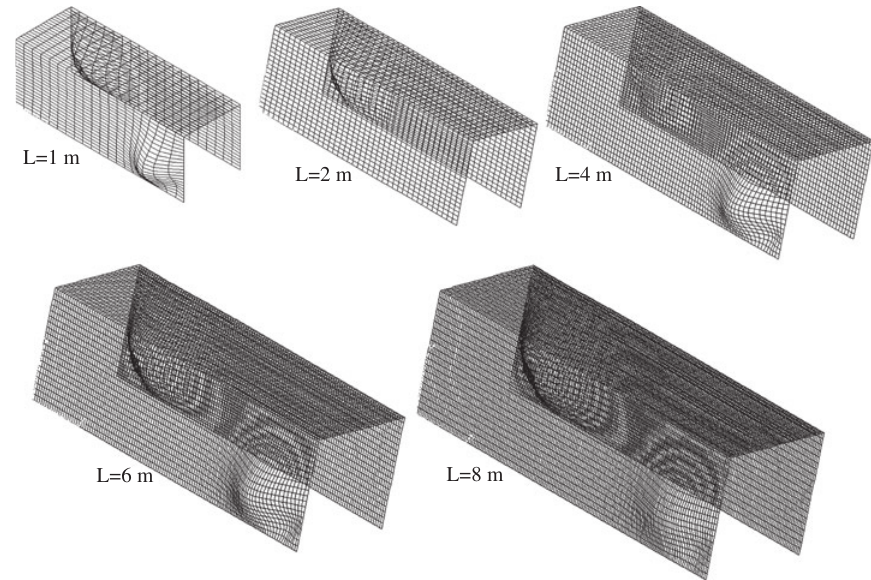
Figure 8 Thermal buckling modes for different plate lengths of two-fold laminated plates.